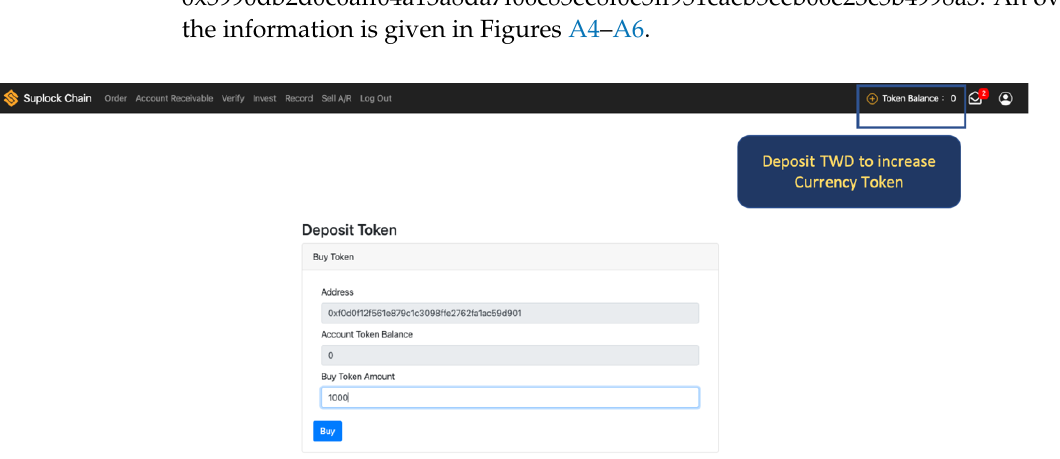
Figure A4. Module for minting currency tokens. Core 1 requests to mint currency token on our website.